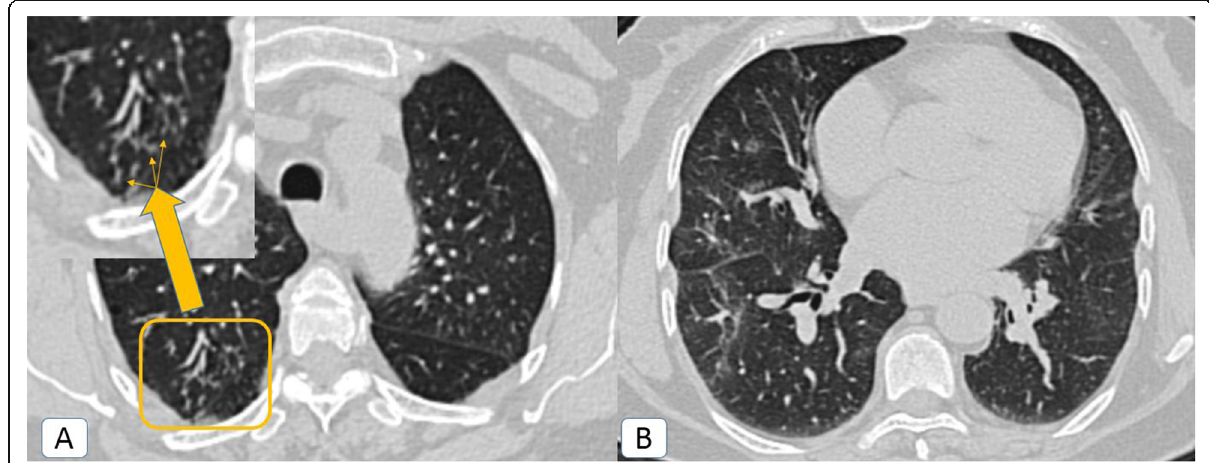
Fig. 9 COVID-19 infection atypically presented by tree in bud nodules: a 71-year-old female COVID-19 patient . A Axial chest CT (lung window) showing small tree in bud branching peripheral sub-pleural micro-nodules in the posterior segment of the right upper lobe (yellow square and yellow arrow pointing to zoomed image). B Axial chest CT (lung window) showing bilateral ground-glass patches as well